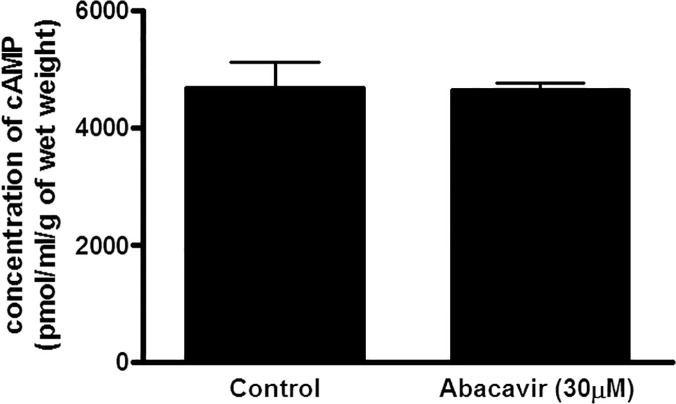
Effect of abacavir on the concentration of cAMP in rat basilar arteries.Rat basilar arteries were incubated without (control) or with 30 μM abacavir for 20 min. cAMP content in arteries was determined using an ELISA kit. Values are means ± S.E.M. of three sets of experiments and statistical comparisons were made using student’s t-test.